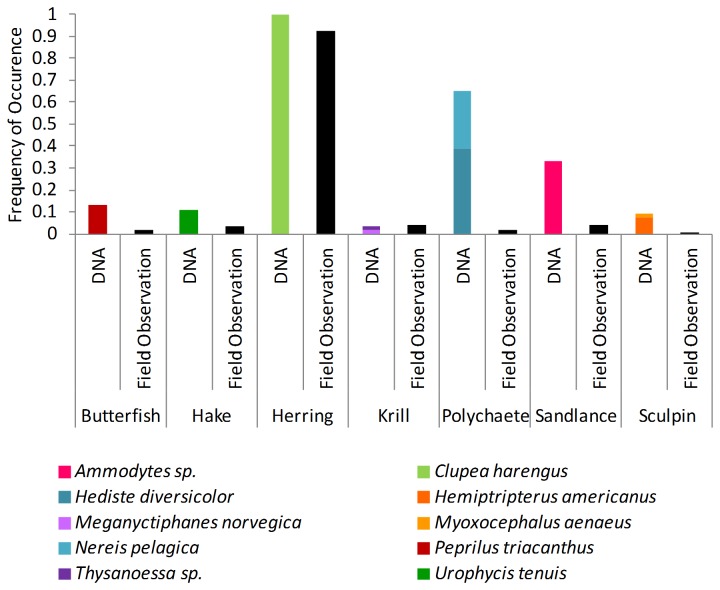
Frequency of occurrence of chick prey through field observations and DNA sequencing.Coloured bars represent DNA-identified taxa which are assigned to one of 7 field observation prey categories (black bars).